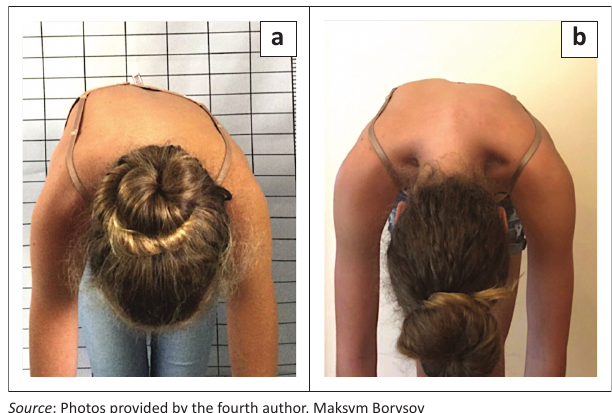
FIGURE 8: (a) Immature patient with a significant rib hump, (b) with a clear improvement of the rib hump as the intermediate result after 12 months of treatment with a Gensingen